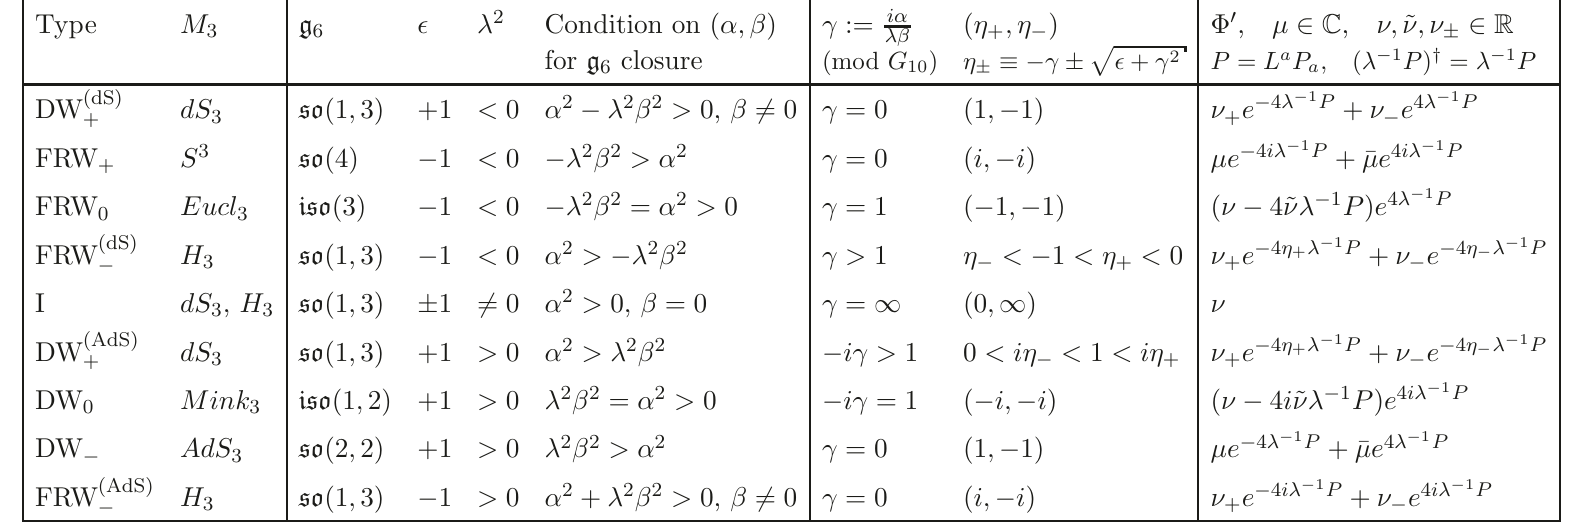
λ 2 β 2 ). The embeddings of g 6 into the − 1 interpolate between the cases with k = 0 −